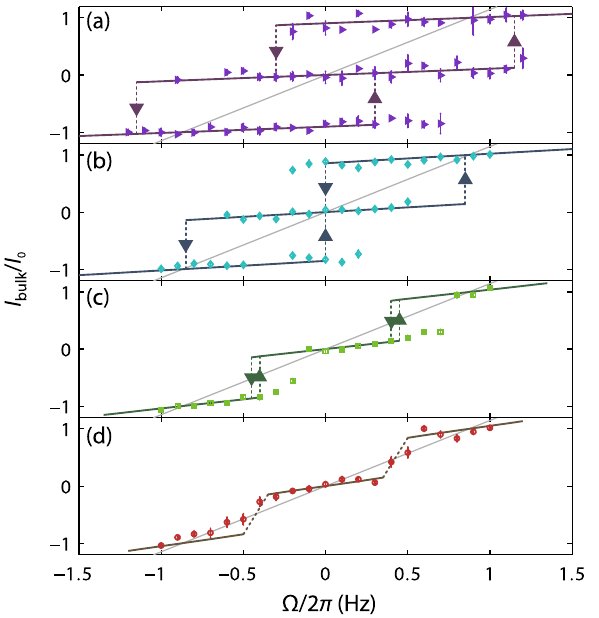
FIG. 3. Plot of the normalized current around the bulk of the =I ¼ α = 2 π , versus the rotation rate Ω of the weak link ring, I 0 bulk for four different weak-link potential strengths U : (a) 0 . 45 μ 0 , (b) 0 . 6 μ 0 , (c) 0 . 7 μ 0 , (d) 0 . 8 μ 0 . The solid lines are the prediction of our model (see text). The dashed, vertical lines show the predicted transitions between the different winding number branches. The thin, gray, diagonal lines represent the case where all the atoms move around the bulk of the ring with the weak link, i.e., I ¼ n R Ω . 1 D bulk